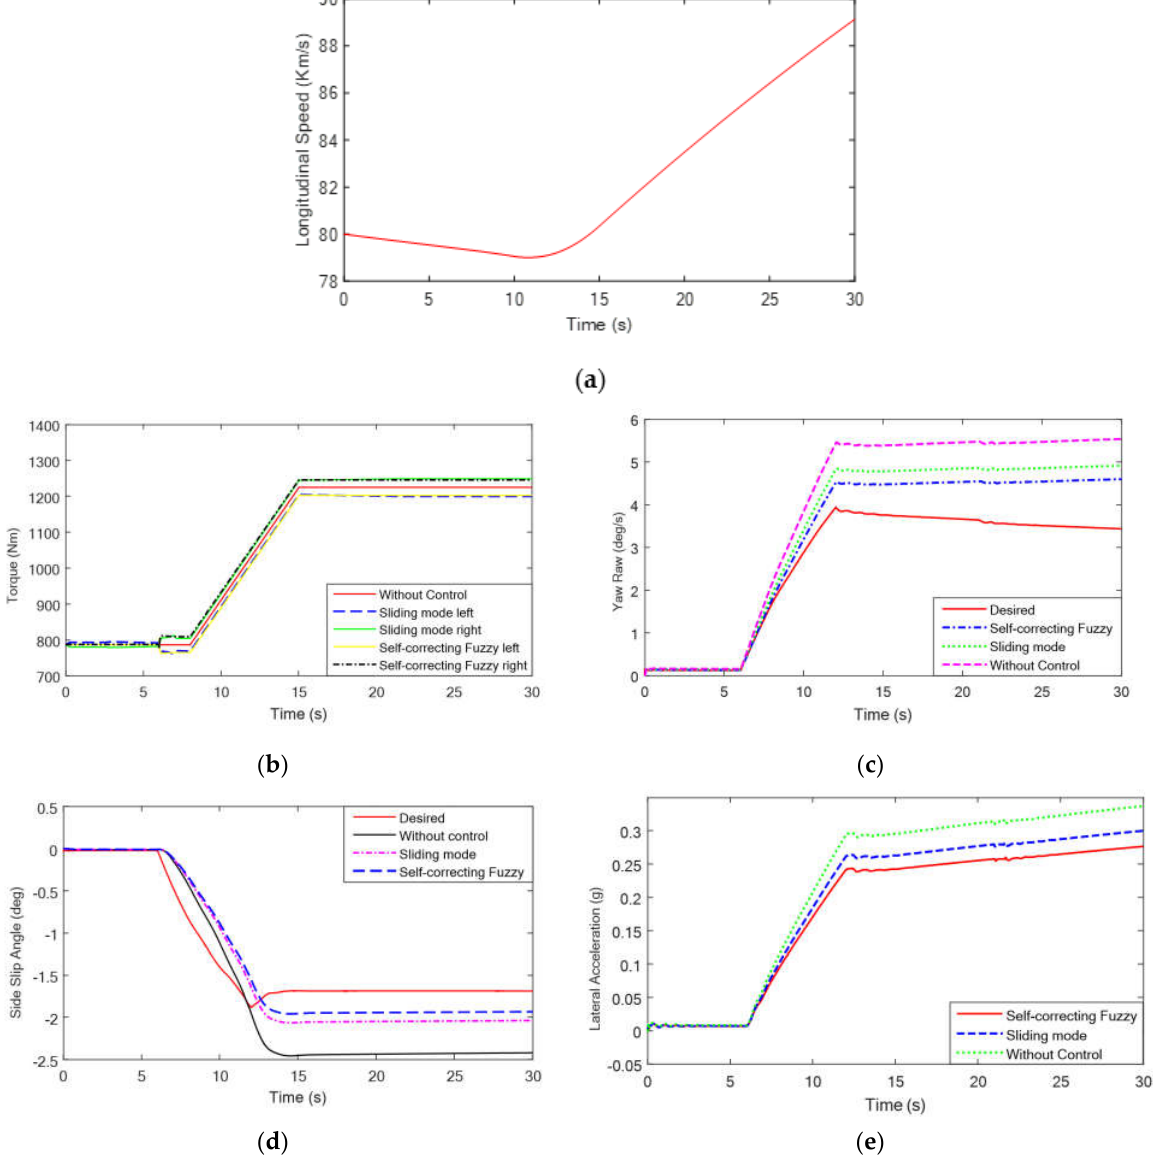
Figure 15. Simulation results of the distributed drive control at a high-speed small-steering-angle step condition: ( a ) Speed; ( b ) Torque ( c ) Yaw Rate; ( d ) Sideslip Angle; ( e ) Lateral Acceleration. Table 6. The maximum values of the main control parameters under the high-speed small-steering- angle step condition.